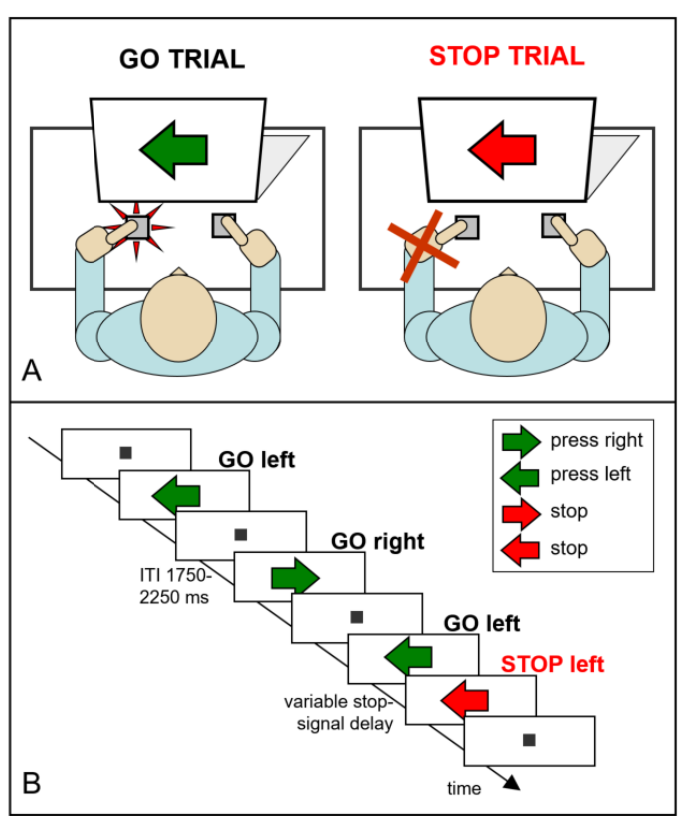
Figure 1. Stop-task design. ( A ) Participants were instructed to press the left or right button in the direction indicated by the green arrow (i.e., go trials). ( B ) On 30% of the trials, the color of the arrow changed from green to red (i.e., stop trials) upon which participants should inhibit their go response.